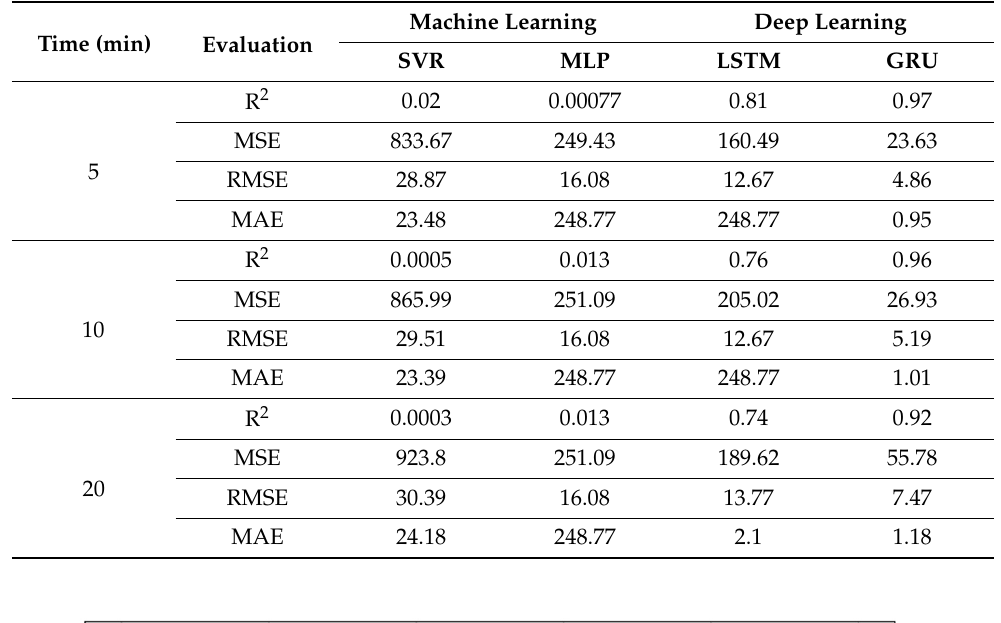
Table 8. Results of Prediction Data for Three Types of data.